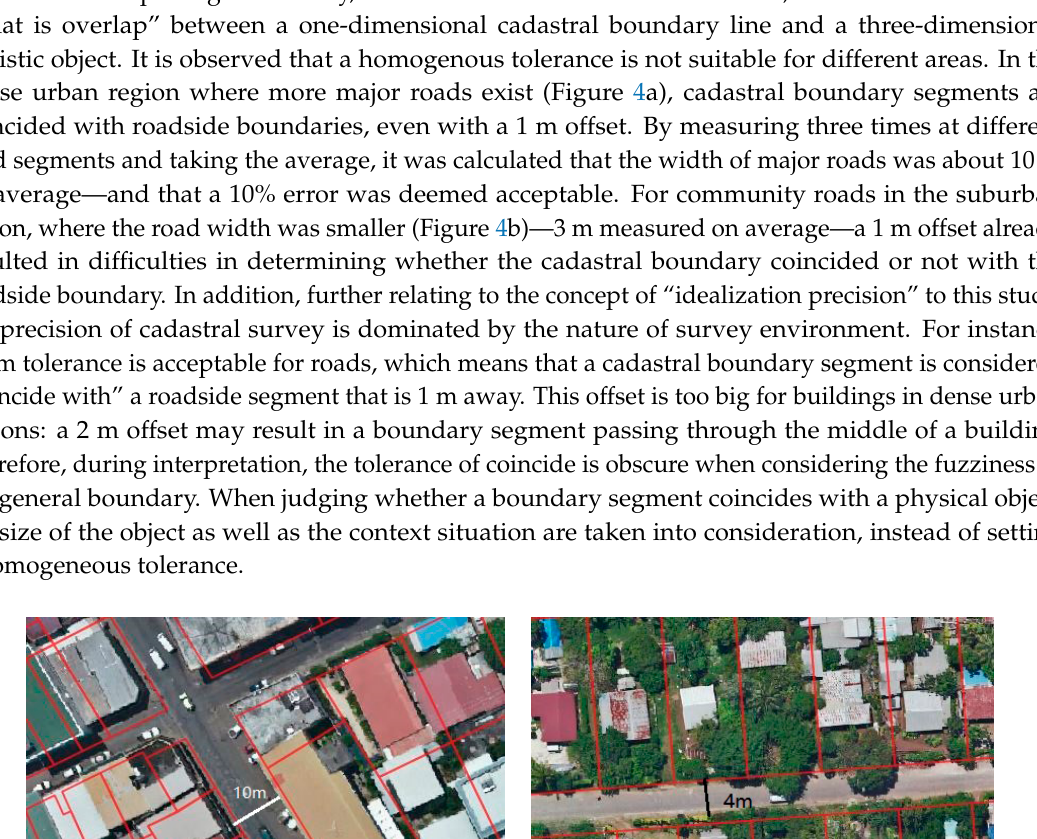
Table 1. The number of cadastral boundaries coinciding with physical objects.